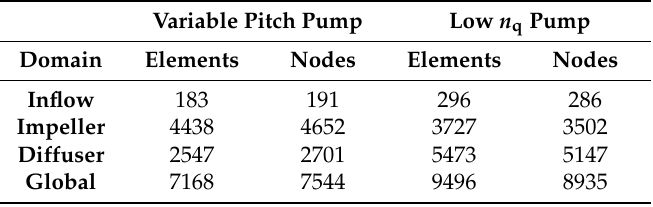
Table 2. Mesh statistics for grid dependency study. a